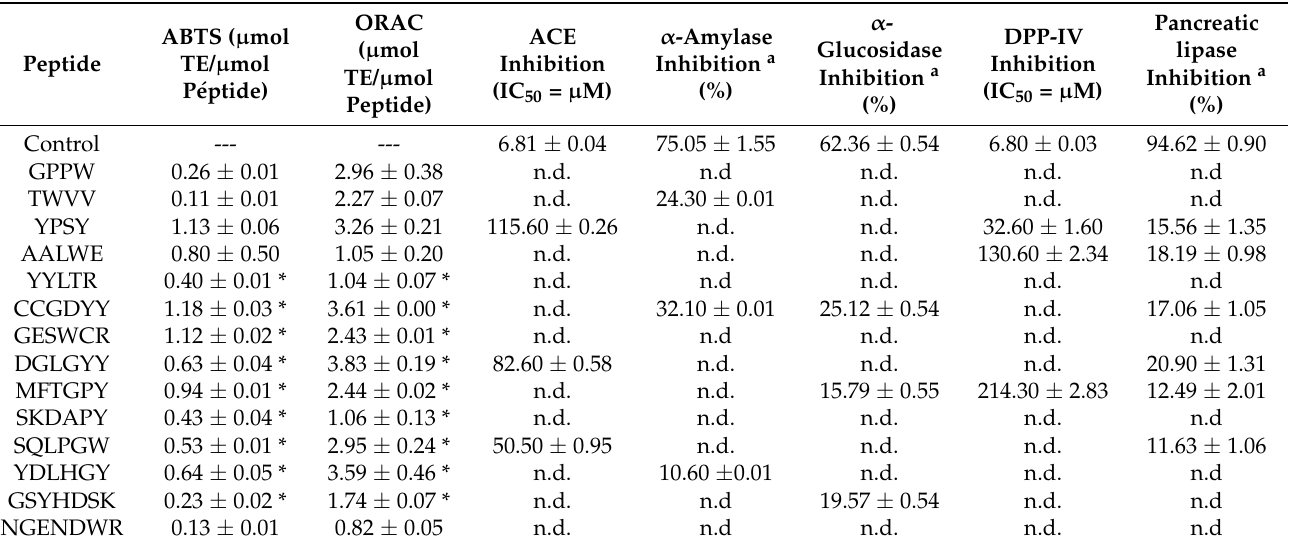
Table 1. In vitro antioxidant, anti-hypertensive, anti-diabetic, and anti-obesity activities of pajuro peptides characterized from Erythrina edulis